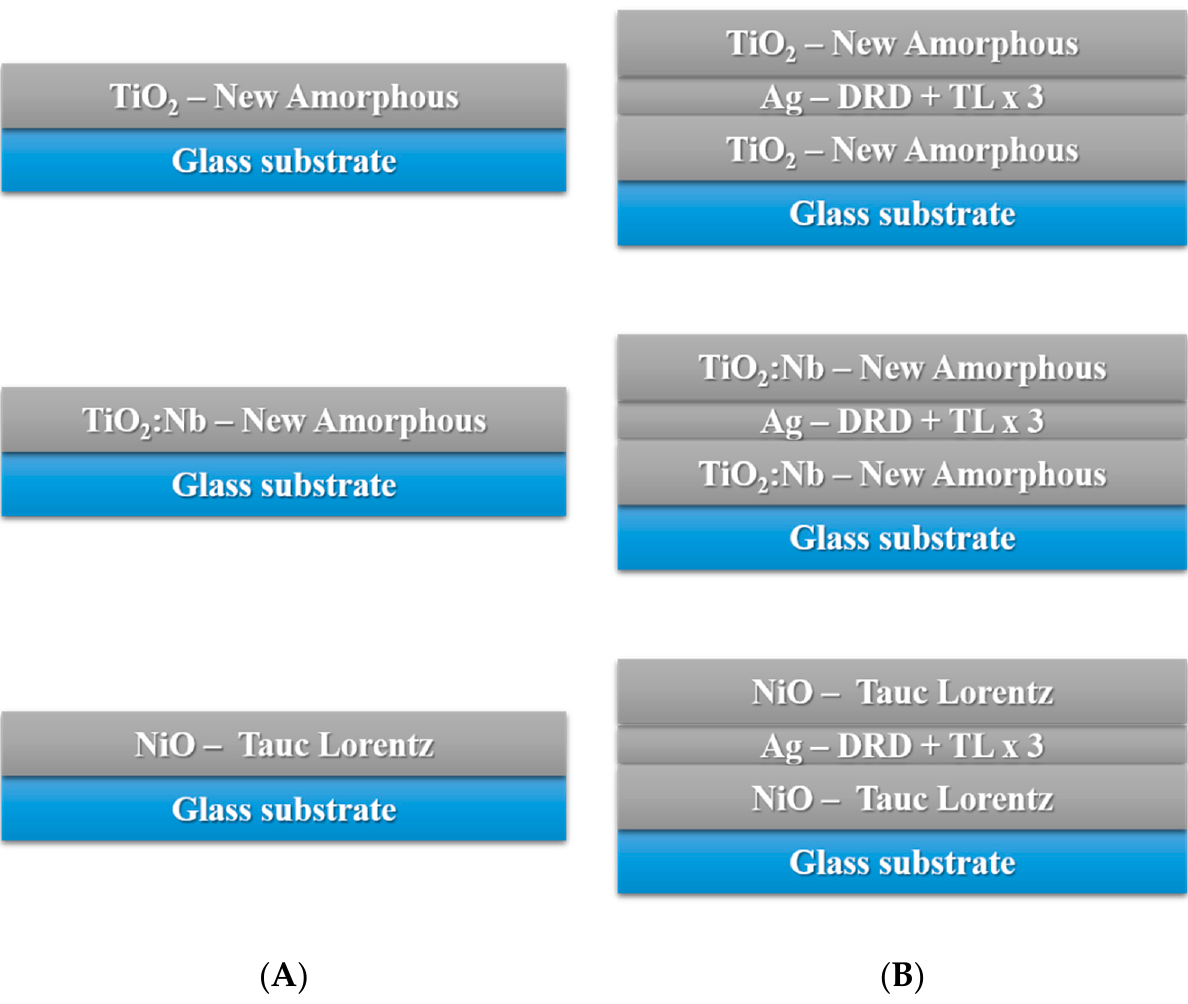
Figure 4. Contact angle measurements with and without UV irradiation for single and three-layer samples: ( a ) TiO 2 ; ( b ) TiO 2 :Nb; ( c ) Nio; ( d ) Ag interlayer.